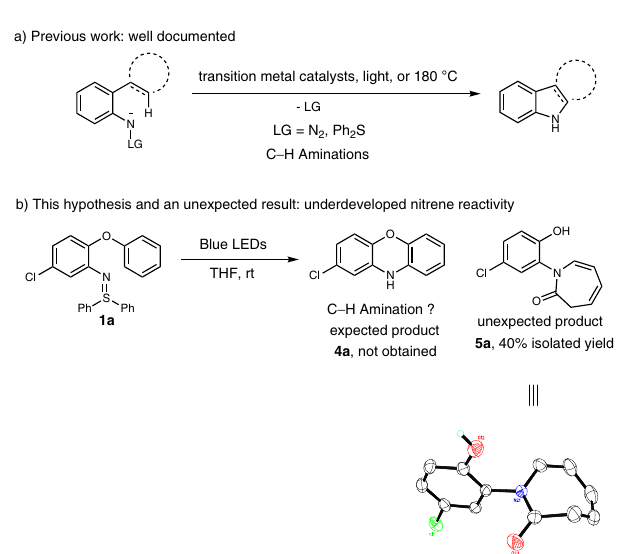
Fig. 2 | Aryl nitrene precursors for aza-heterocyclic syntheses. a Previous work: synthesisofcarbazolesandrelatedheterocyclesthrough2-alkyl,2-alkenylor2-aryl arylnitrene intermediates. b Thiswork: synthesis of azepinone derivatives through 2-aryloxyaryl nitrene intermediates.